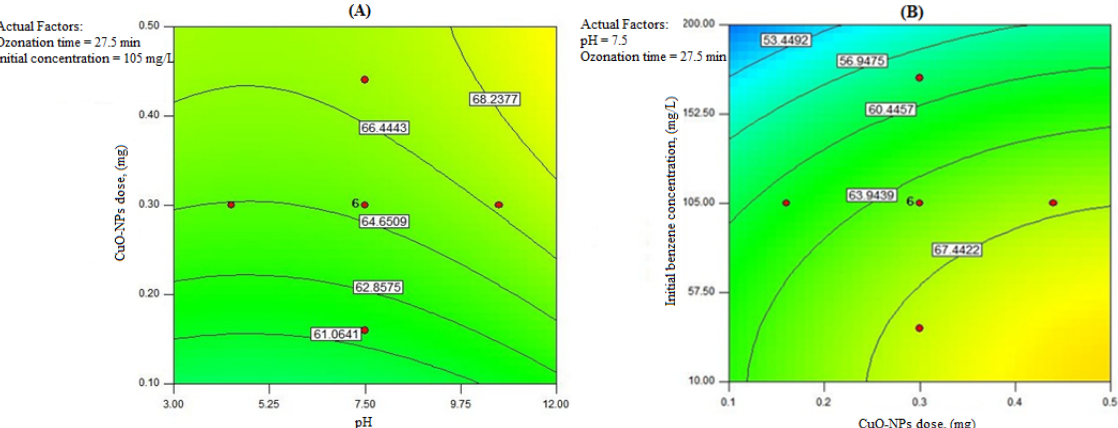
Fig. 6: The effect of catalyst dose on efficiency of benzene removal